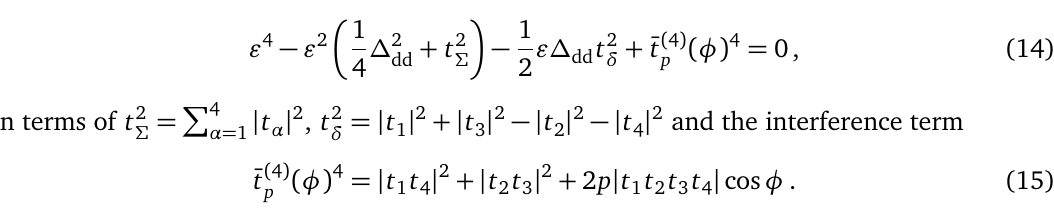
Figure 3: Eigenenergies of the Hamiltonian (13) for different parities p and as a func- tion of QD-QD detuning ∆ for various values of QD-island detuning ∆ dd | = | t | = 1.5 t , | t | = | t | = t . Panel (a) is given by the analytical expressions set | t 1 2 3 4 of Eq.